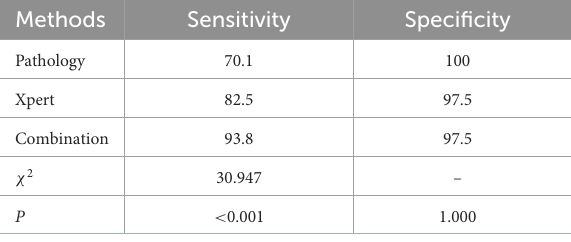
TABLE 2 Comparative results of pathological examination, Xpert test, and their combination in terms of sensitivity and specificity (%). Methods